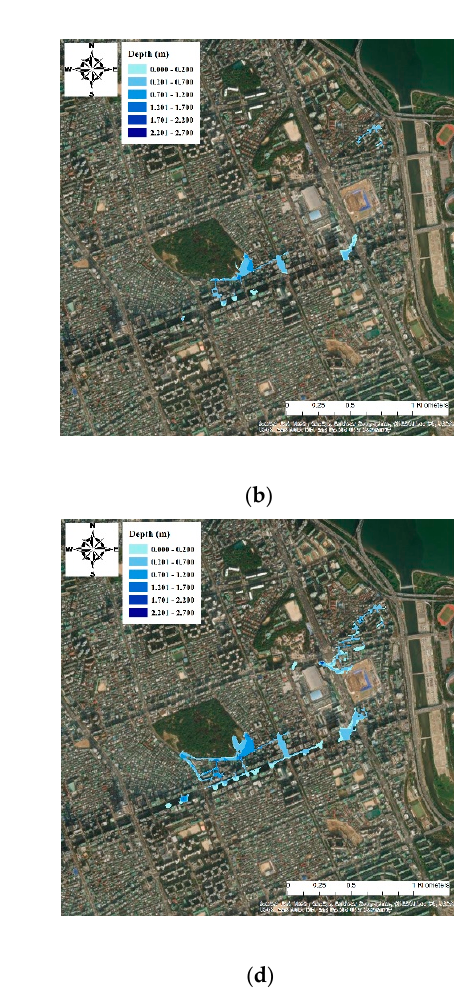
Figure 7. Sample minimum inundation maps applying 100-year, 1-h rainfall events with different Huff quartile distribu- tions (( a – d ): 1st, 2nd, 3rd, and 4th quartile).